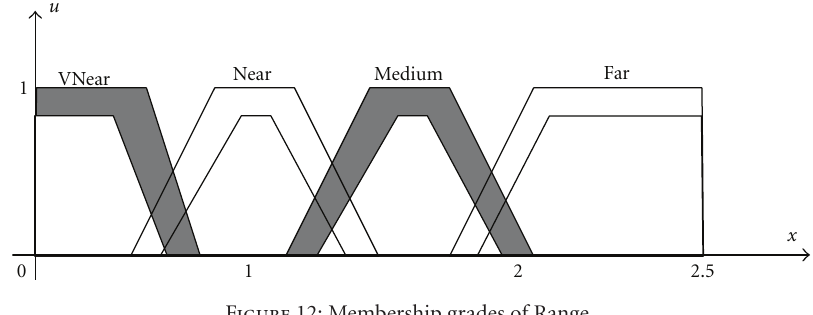
Figure 12: Membership grades of Range.